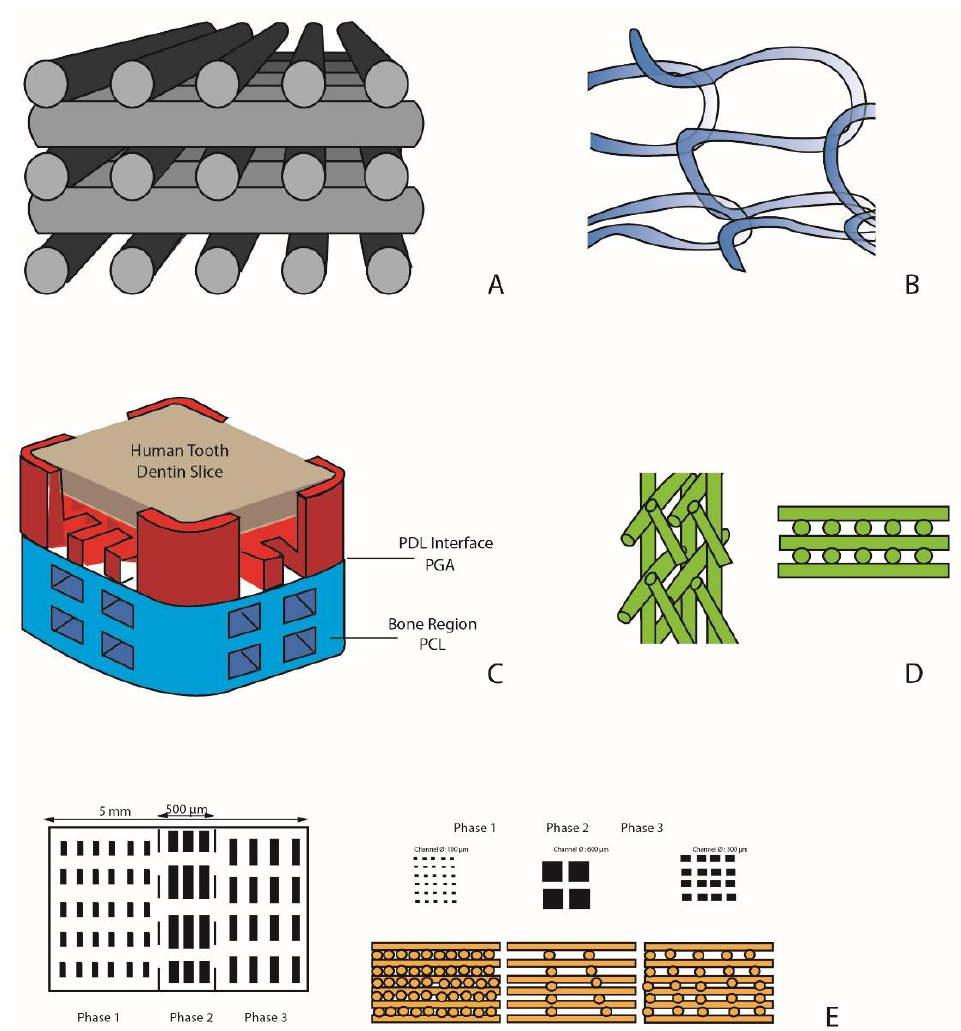
Figure 2. Sca ff old designs. ( A ) porous block of laminated strands of biphasic ceramic ( α -tricalcium phosphate (TCP) + hydroxyapatite (HA)) [132]; ( B ) monophasic sca ff old of poly-L-lactic acid mesh associated with Bone Marrow-derived Mesenchymal Stem Cells with platelet-rich plasma (PRP) [131]; ( C ) biphasic sca ff old with two compartments: a bone compartment (poly- ε -caprolactone PCL) and a ligament compartment (acide polyglycolique PGA) [135]; ( D ) biphasic sca ff old with a bone compartment and a ligament compartment [89]; ( E ) three-phase sca ff old with distinct phases corresponding to the morphology of the periodontal complex: cement, periodontal ligament, and alveolar bone